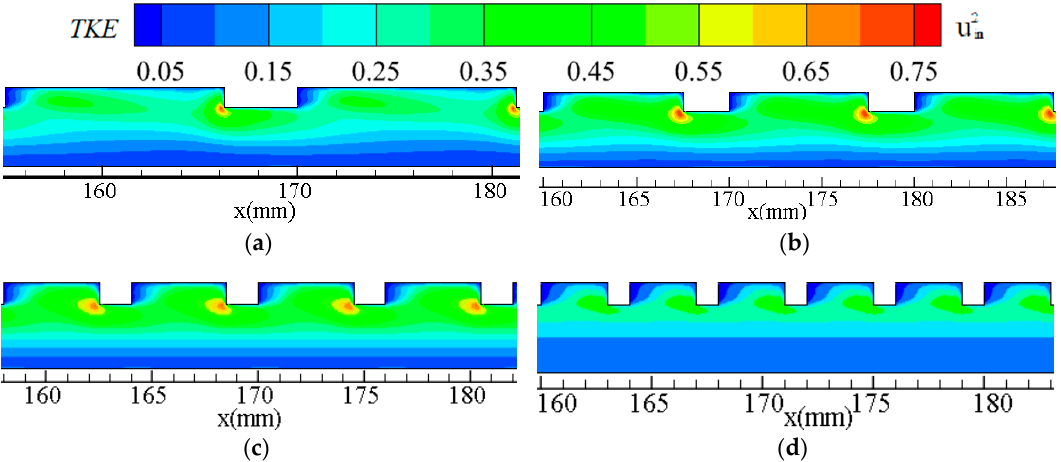
Figure 15. Contours of turbulence kinetic energy (TKE) in a narrow channel under different L u